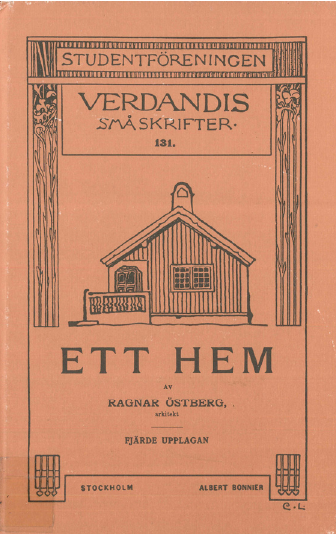
Figure 9. Ragnar Östberg (1866–1945): Ett Hem (“ A Home ”), Stockholm, Albert Bonniers Förlag, 1906, cover.